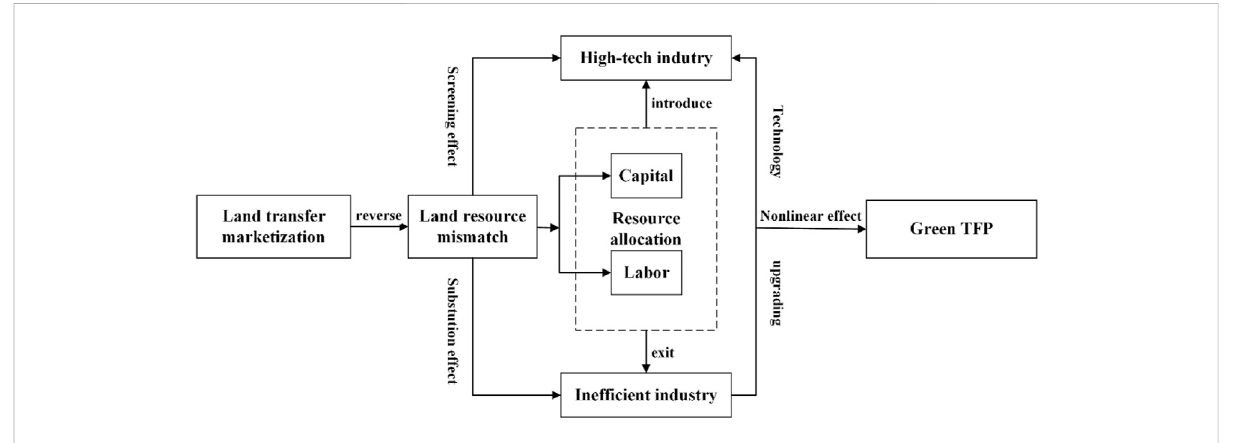
FIGURE 1 Theoretical model of LTM, resource allocation, and green